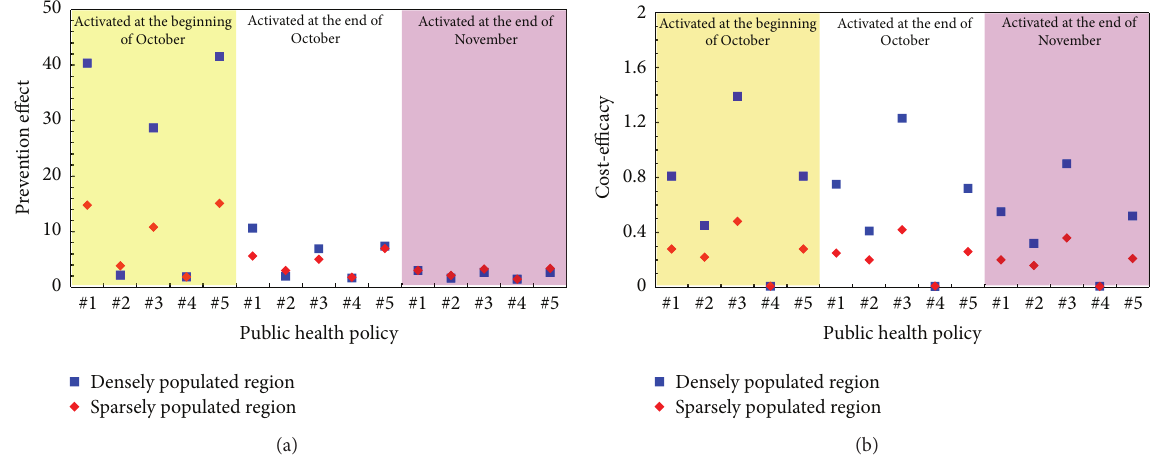
Figure 15: Comparisons of (a) prevention effects and (b) cost-efficacies among five intervention